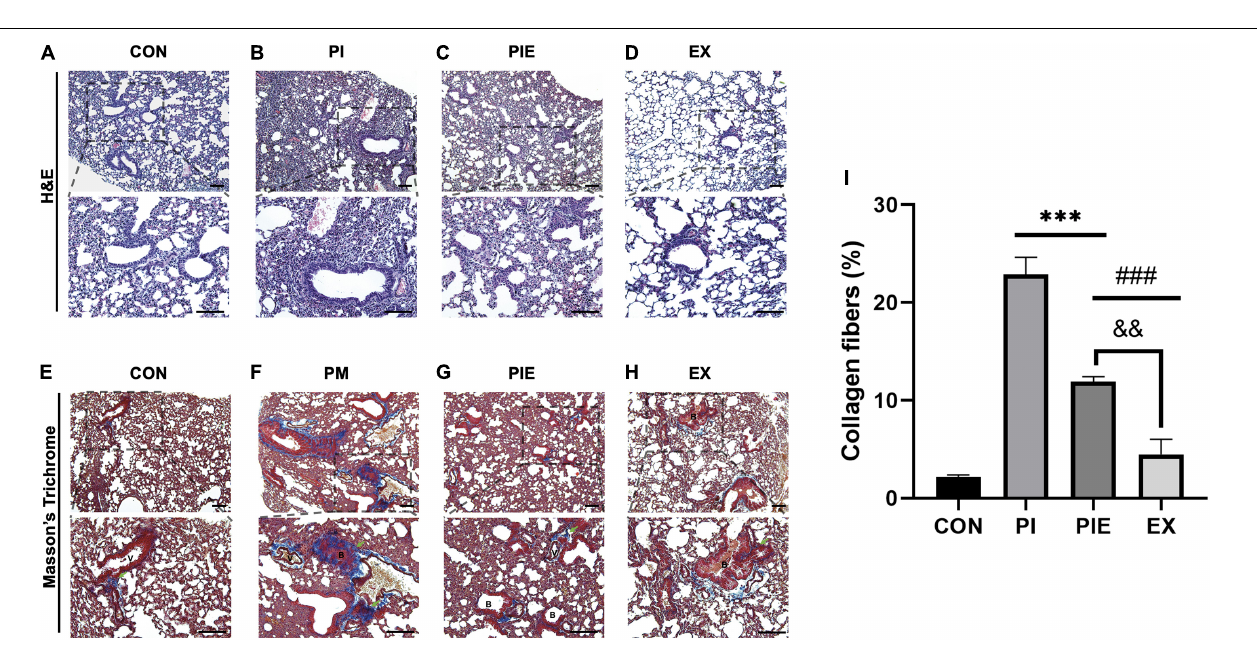
Frontiers in Physiology |